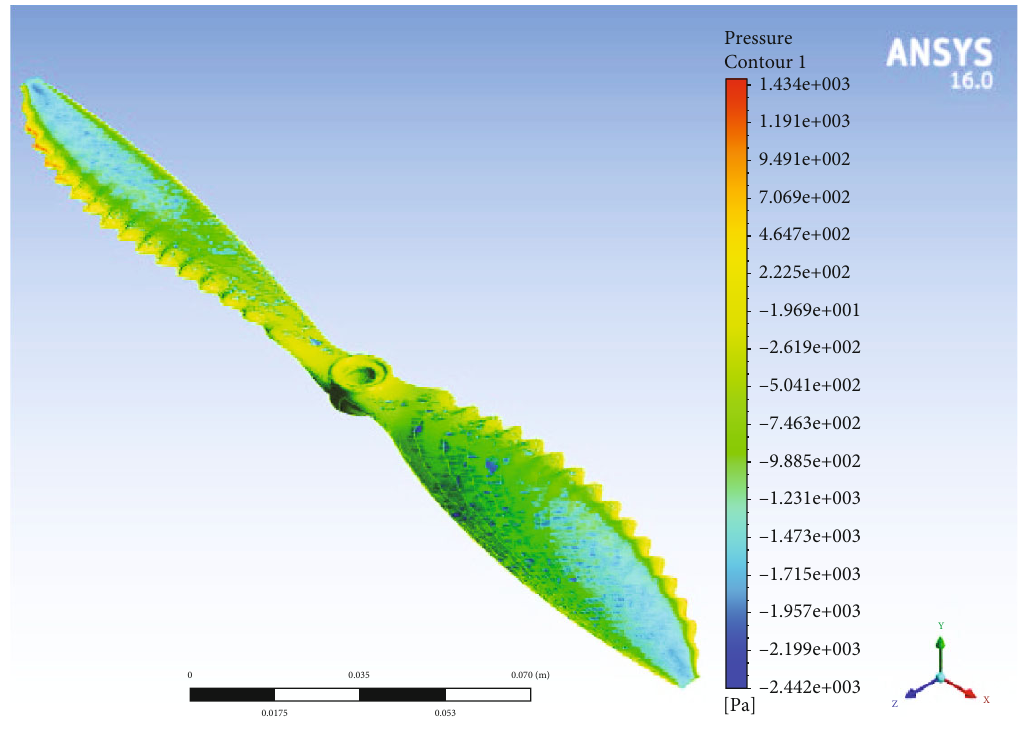
Figure 24: Pressure contour at 0 ° C temperature.